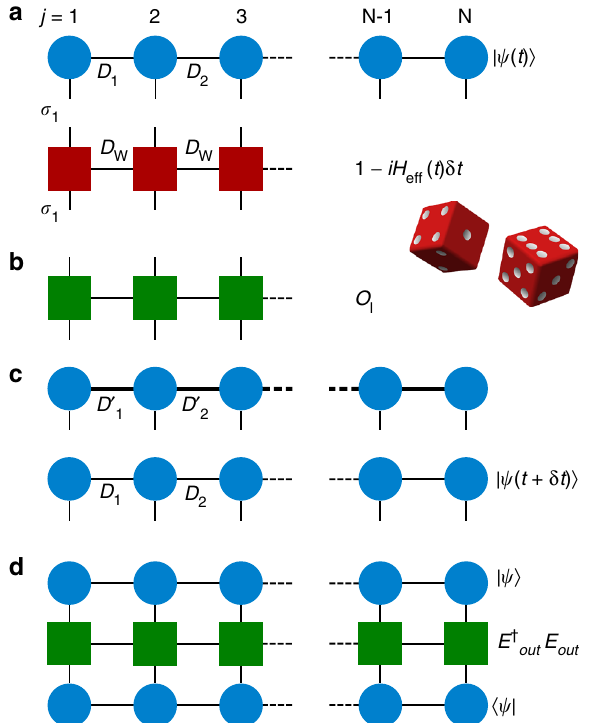
Fig. 2 Schematic of MPS operations. a Deterministic time evolution of MPS. The initial state | ψ ( t ) 〉 in MPS form is presented pictorially as a tensor network, where the circles represent the set of local matrices A σ j on each site j . The lines or bonds joining the circles represent the contraction of these local tensors to give the state | ψ ( t ) 〉 , where the bonds have dimension D j . The open ended lines correspond to the local d -dimensional Hilbert space of the atoms σ j . The deterministic evolution is then found by contracting these open connectors with those of the MPO representing e (cid:2) iH eff δ t (cid:7) 1 (cid:2) iH eff δ t , shown as a tensor network of red squares. b Quantum